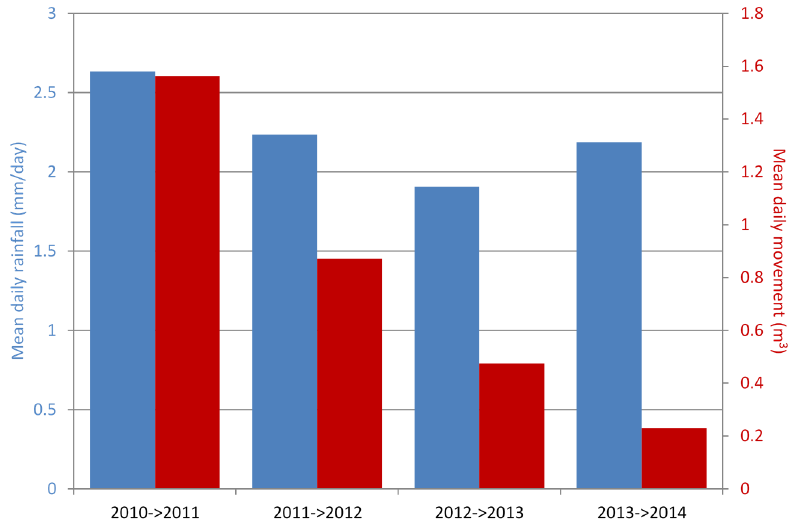
Figure 7. Comparison of annual rate of rainfall and annual rate of accumulation of material for the little toe area of the Home Hill